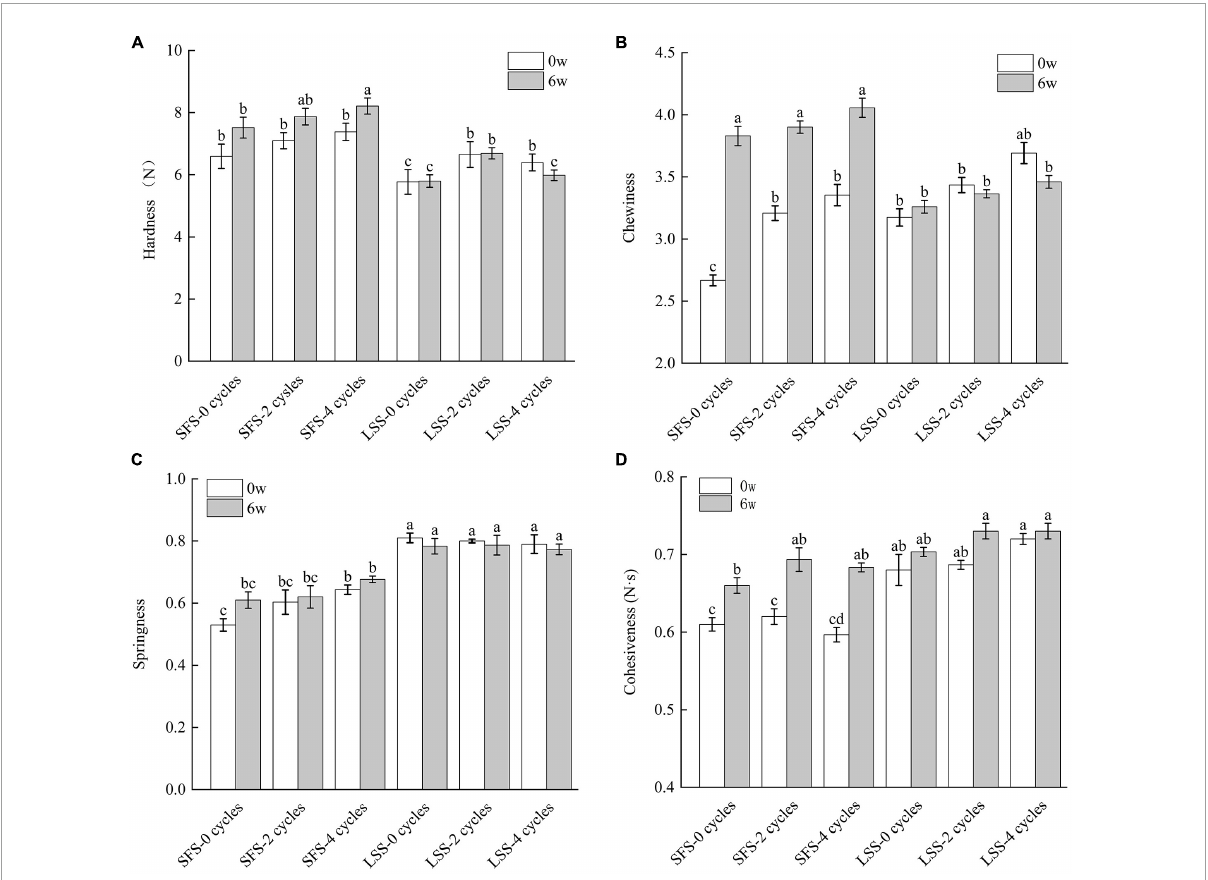
FIGURE2 Texture changes of LYC during frozen storage; panels (A–D) present the hardness, cohesiveness, springiness, and chewiness, respectively. SFS and LSS represent the salt-free soaking group and low-salt soaking group, respectively. Different letters in the figure represent significant differences between the six samples ( P < 0.05).